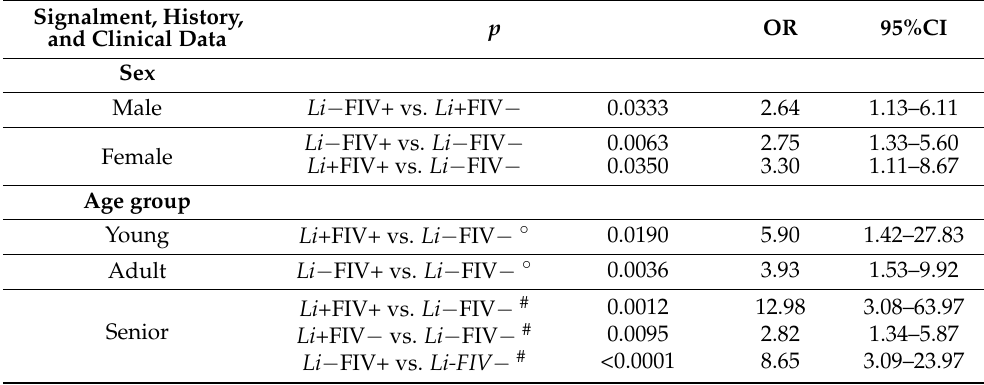
Table 3. p -value, odds ratio (OR), and 95% confidence interval (CI) for the significant differences concerning signalment, history, and clinical